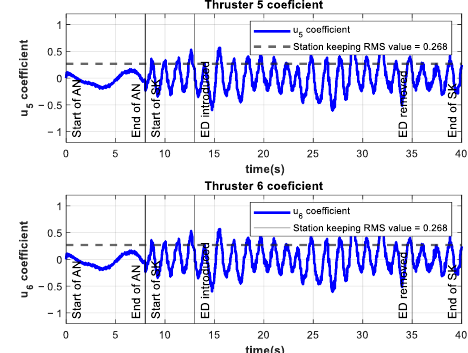
introduced in the interval 13 s ≤ 𝑡 ≤ 25 s . Depth ( left ) and tracking error ( right ).